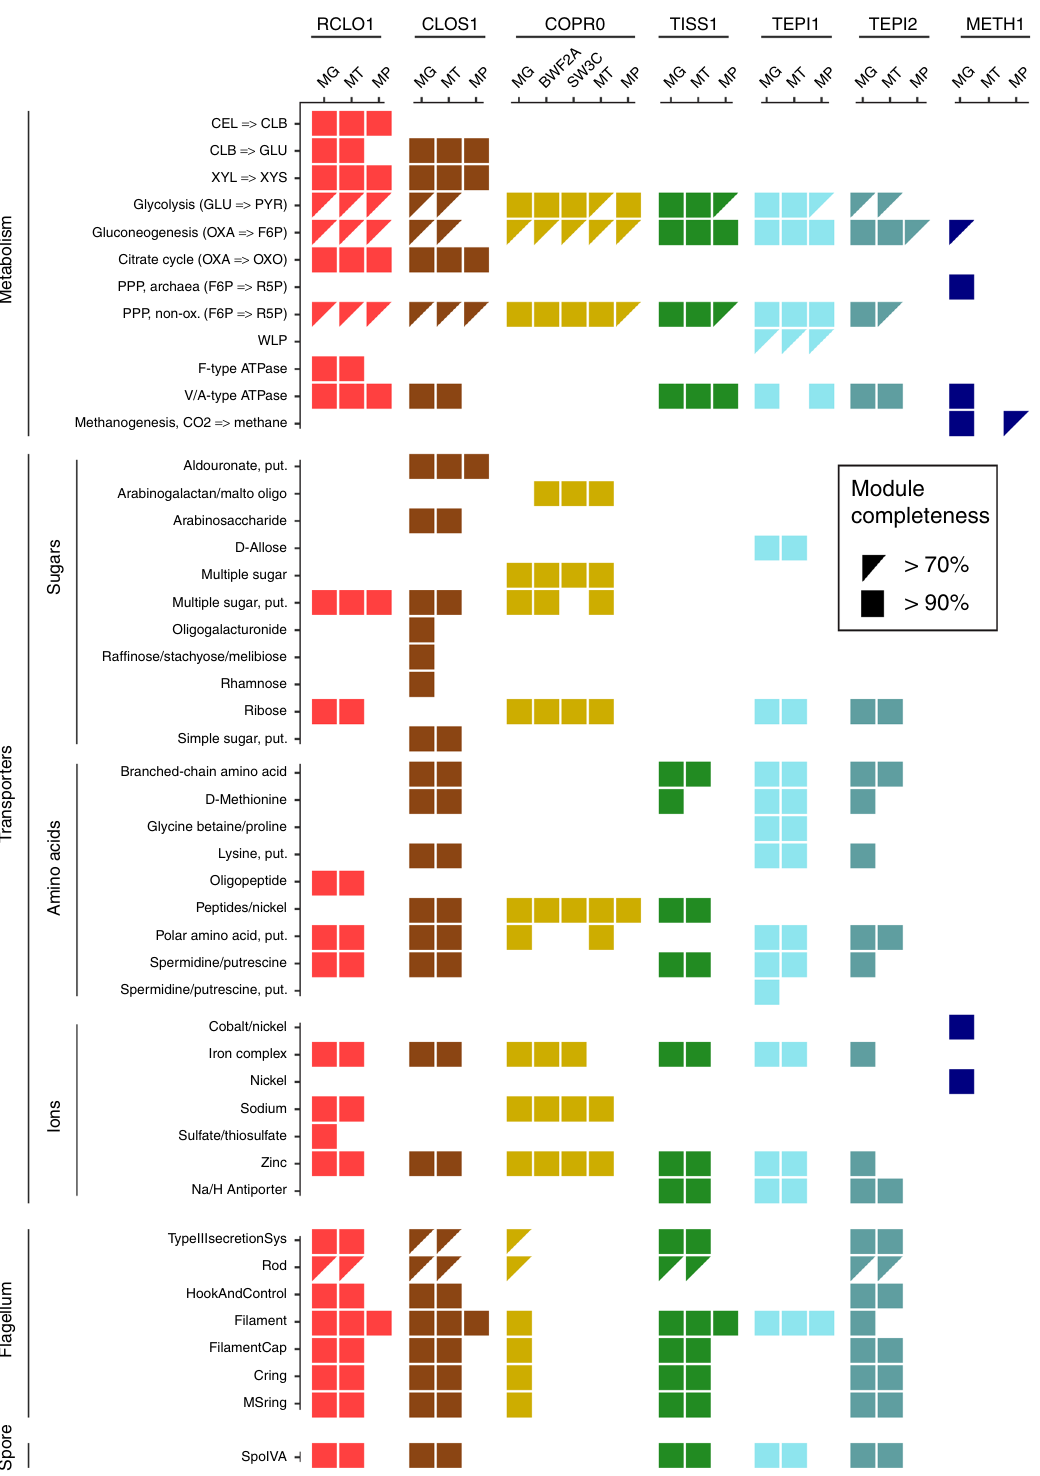
Fig. 3 Overview of the genetic potential and expressed modules in SEM1b. Module completeness denotes the level of detected RNA and proteins mapped to major genes/metabolic pathways that are critical to the SEM1b life cycle. Triangles denote completeness greater than 70% while square completeness >90%. Only MAGs with the highest quality reconstruction (RCLO1, CLOS1, COPR1, TISS1, TEPI1, TEPI2, and METH1) are included as well as two isolated and genome-sequenced Coprothermobacter strains, for which the transcriptome and the proteome were considered as the species